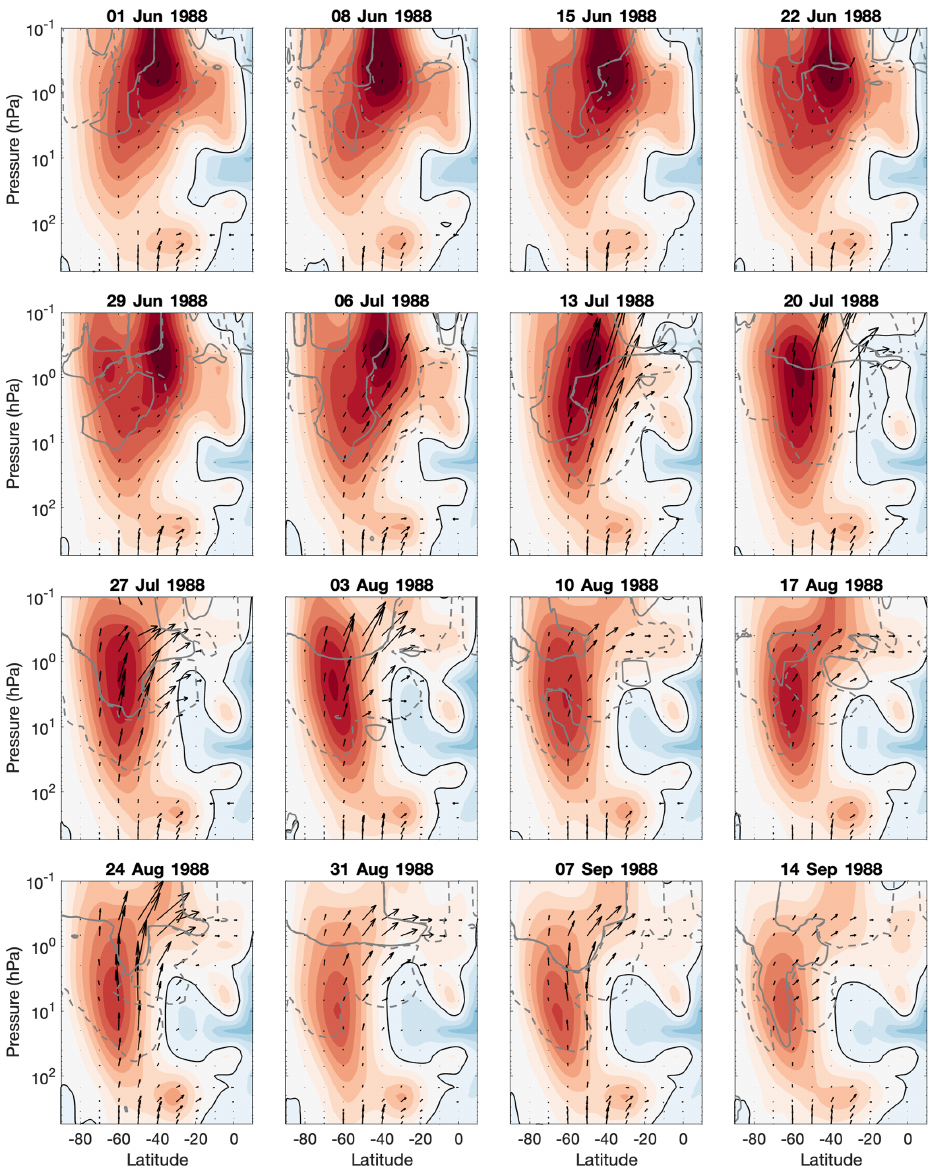
Figure A1. The same as Fig. 1 but for the year